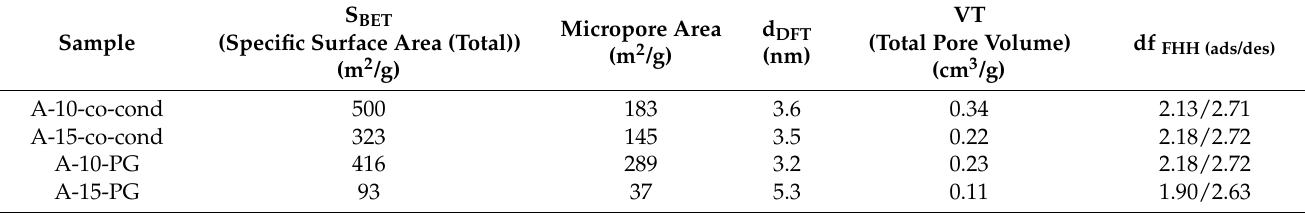
Table 1. Textural parameters of the samples determined by N 2